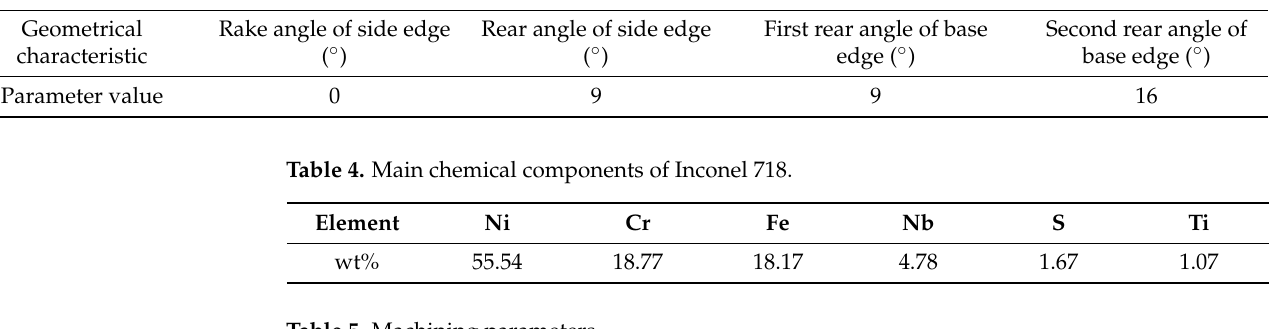
Table 5. Machining